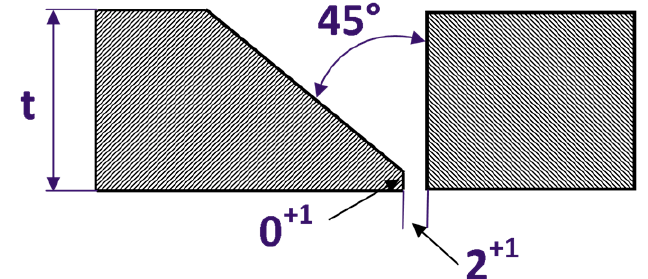
Figure 3. Groove